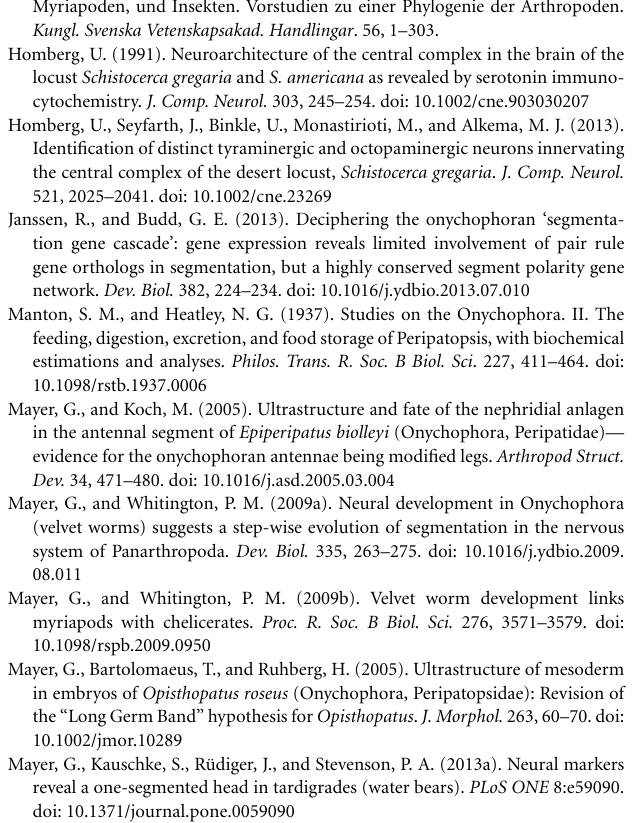
Supplementary Figure S1 | Structure of the posterior-most lip papillae surrounding the mouth in the onychophoran Euperipatoides rowelli . Stereomicrograph; anterior is up. Arrowheads point to bilaterally arranged sensilla of the posterior-most lip papilla (number 8). Abbreviations: dm, definitive mouth opening. Scale bar: 100 μ m. Supplementary Figure S2 | Characteristics of nerves supplying the lip papillae in Euperipatoides rowelli . Maximum projection confocal micrographs of a late stage VII embryo. Lip papillae surrounding the